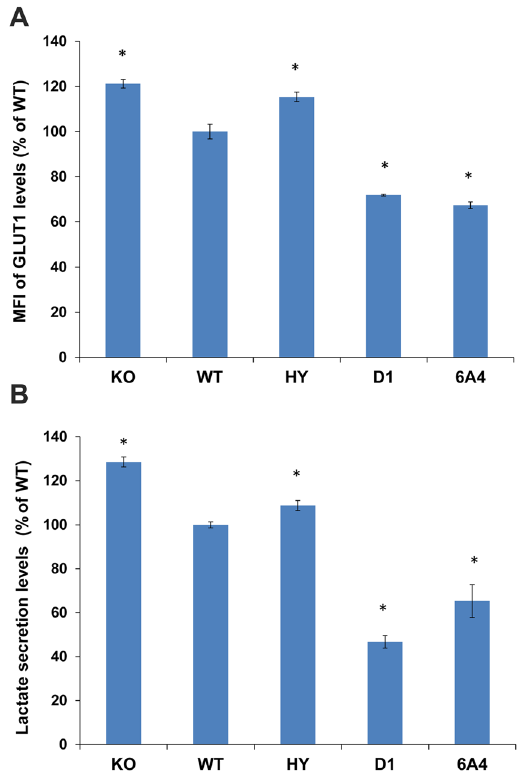
Figure 5. Glucose Metabolism of D1 and 6A4 SIRT6 mutants is enhanced relative to the WT. ( A ) Analysis of the expression level of GLUT1 on cells. KO MEFs expressing the different SIRT6 variants were analysed by flow cytometry to measure the level of GLUT1 on the cell membrane. The mean fluorescent units (MFI) of the flow cytometry signal of all mutants were normalized to the WT level. ( B ) Lactate secretion levels from the MEF cell lines expressing the different SIRT6 variants were obtained by measuring NADH formation following incubation with lactate dehydrogenase. All results are normalized to the WT lactate secretion level. The data presented is the average of three independent technical repeats of each experiment while the error bars represent the standard deviation from the average. Statistically significance differences of the different SIRT6 variants or the KO from the WT MFI ( A ) or lactate levels ( B ) are labeled with black star (p < 0.05). The expression level of the different SIRT6 variants is very similar and is shown in Fig.